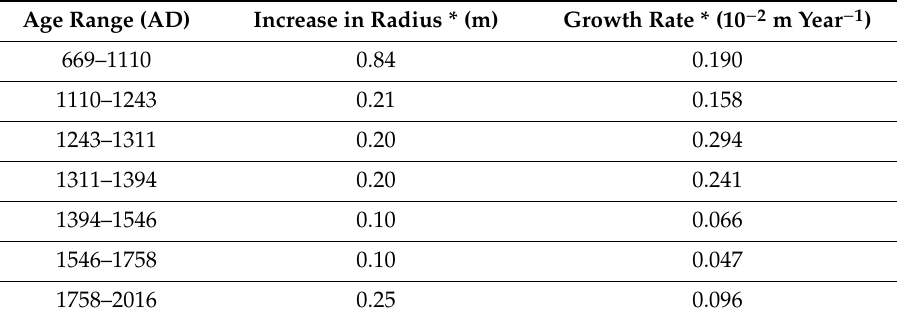
Table 3. The growth rate variation of stem 3 during its life